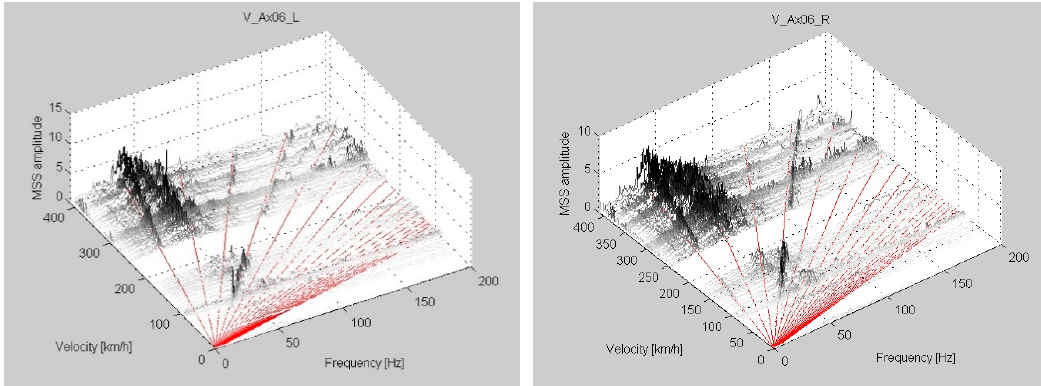
Figure 7. The vibration acceleration spectrogram on the axle and folding e ff ect at the vertical direction of right side of number 6 axle V_Ax06_R: ( left ) 3D spectrogram of FFT analysis of vibration acceleration with train speed, ( right ) 2D spectrogram of vibration acceleration frequency and train speed, the downward wisps (blue dash line) are caused by the folding e ff ect. The folding e ff ect appears stronger at high frequencies at high speeds and less strong at the middle frequencies at high speeds. The wheel rotation speed (wheel diameter 860 mm) and its integer multiples (harmonic frequencies) are plotted with red lines in the spectrograms.